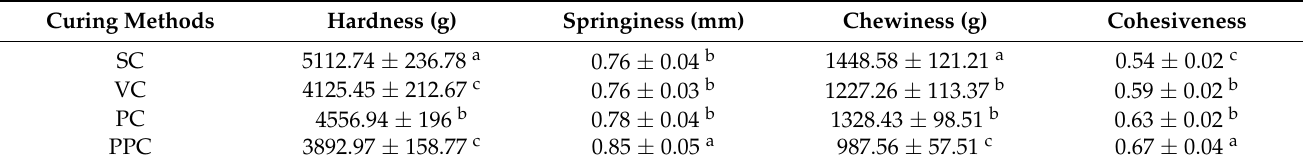
Table 1. Texture of beef with different curing treatments.